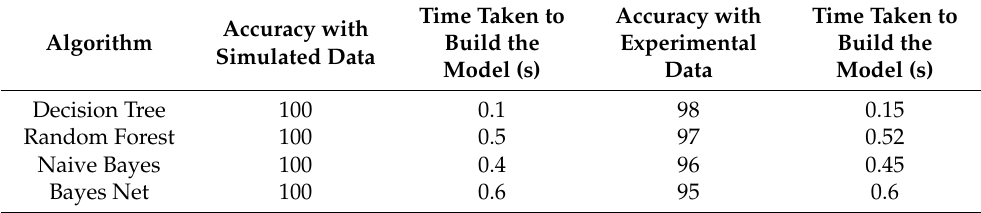
Table 9. Comparative